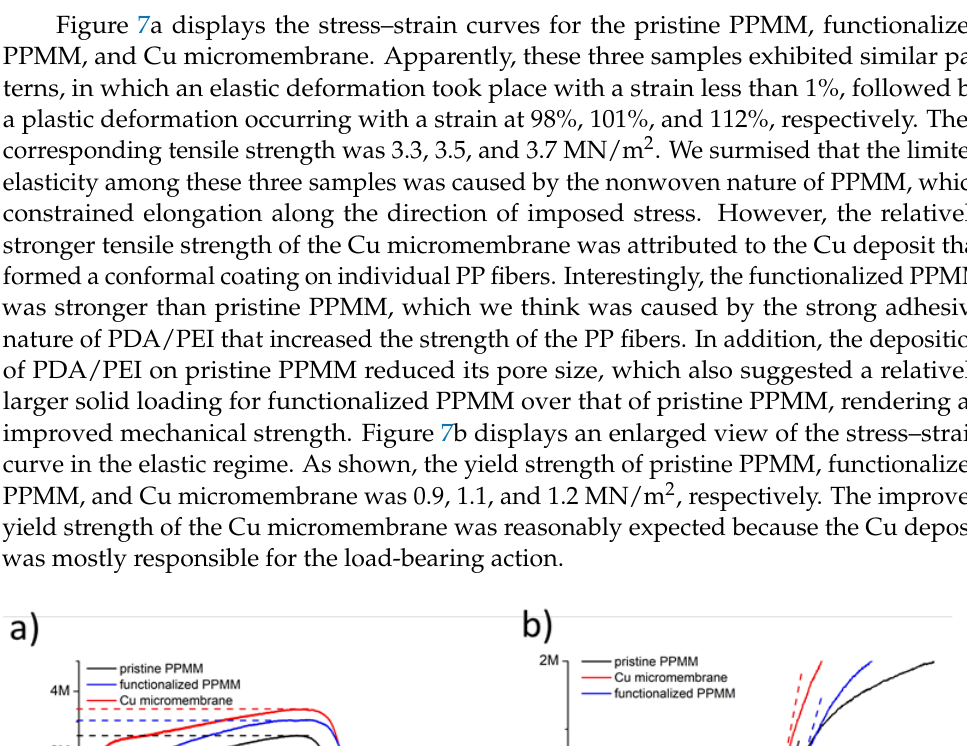
Figure 6. The TGA profiles for pristine PPMM, functionalized PPMM, and Cu micromembrane.